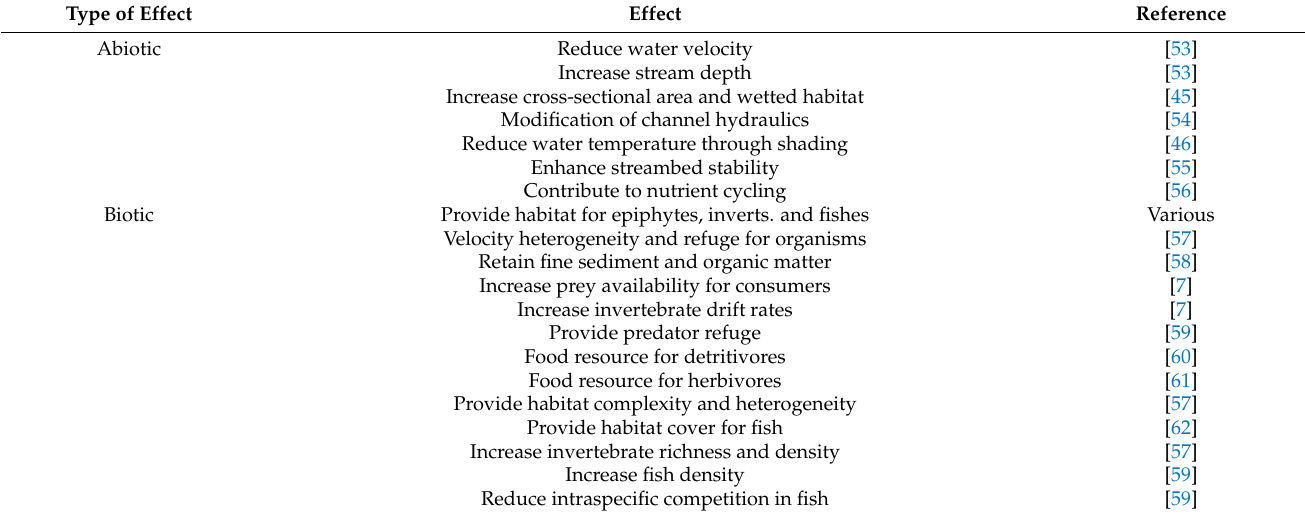
Table 1. Abiotic and biotic effects associated with aquatic macrophytes on volcanic spring-fed rivers. Type of